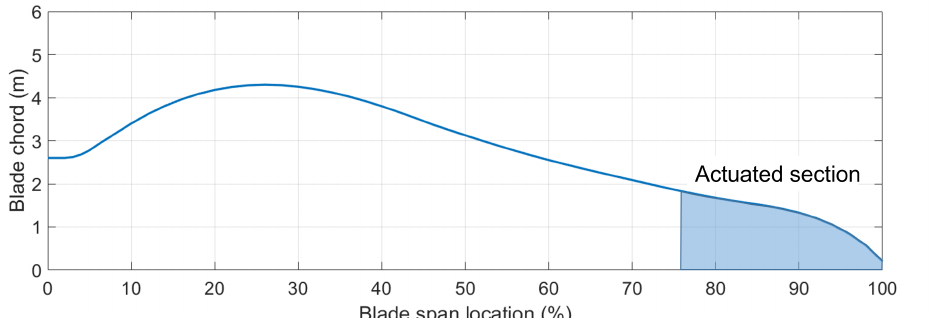
Figure 2. Turbine blade plot with chord length and actuated